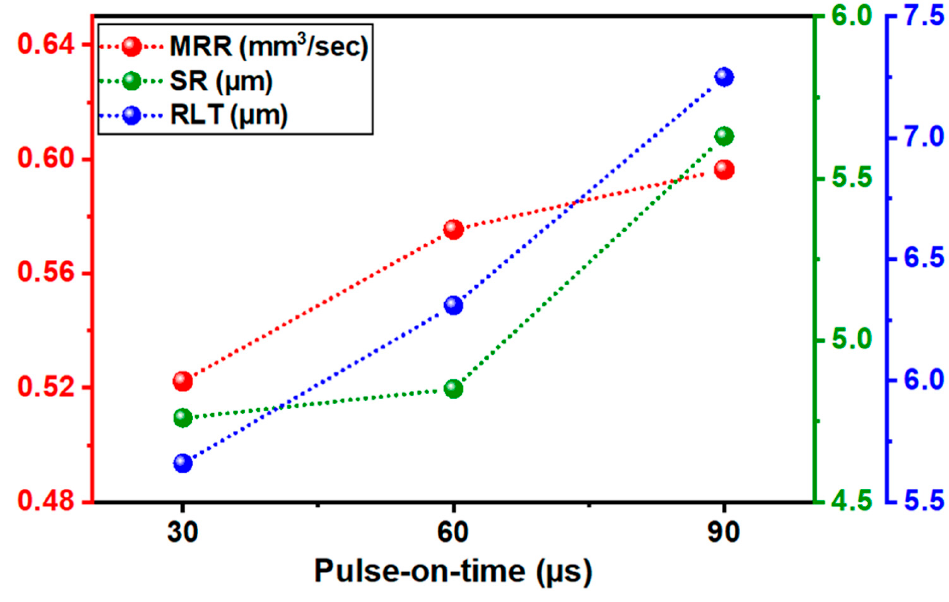
Figure 3. Effect of T on on MRR, SR, and RLT.